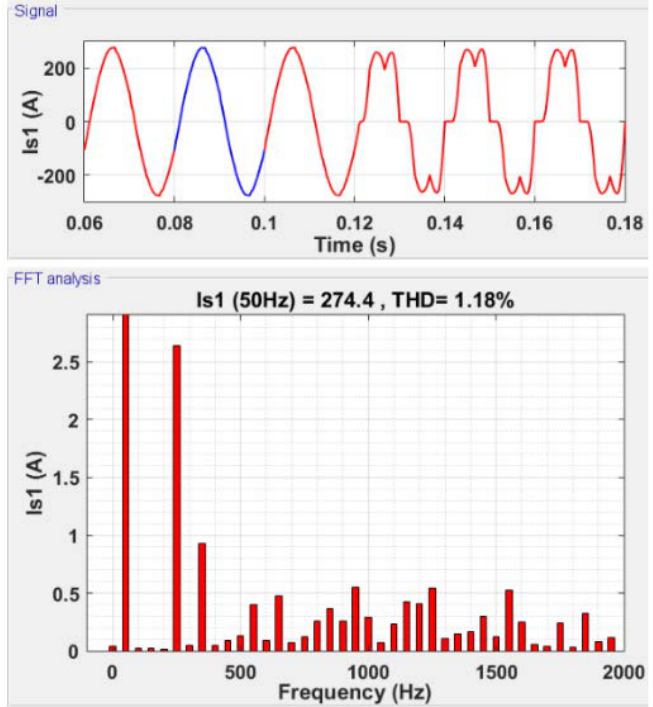
Figure 8. Current filtering using the C-HOSM controller.